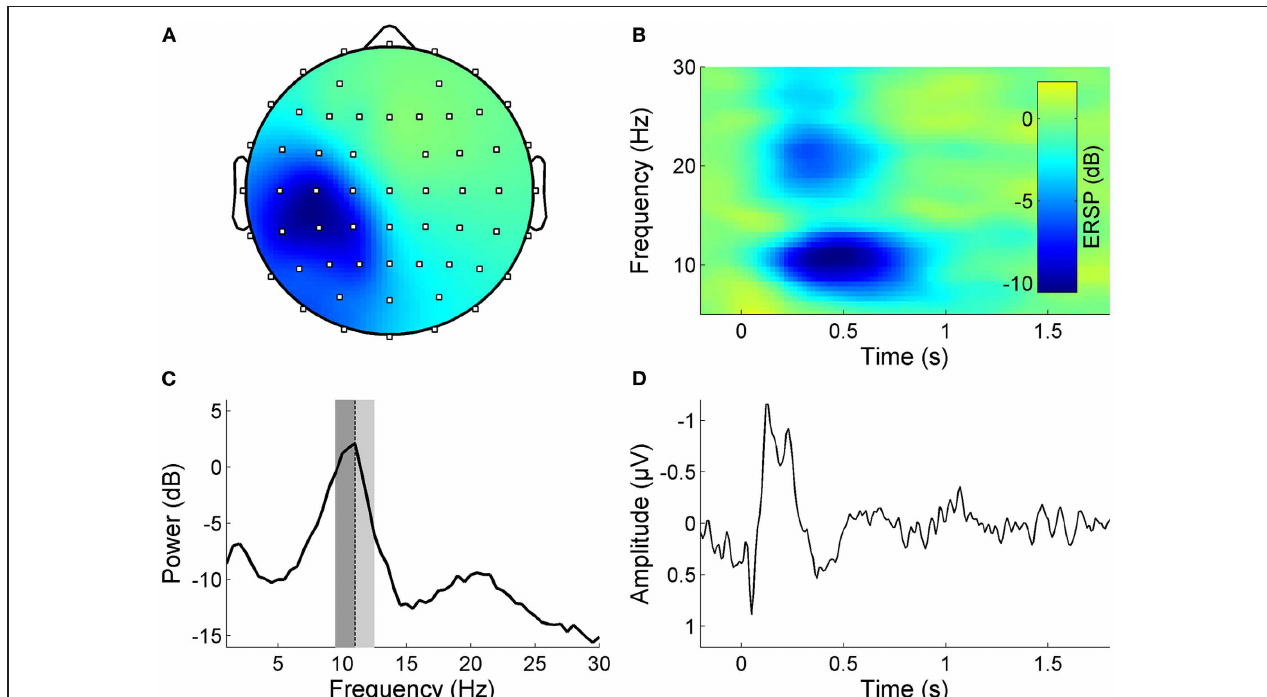
FIGURE 1 | Properties of a somato-IC reflecting sensorimotor activity in a representative subject. (A) Scalp map projection of IC weights (dots display channel locations, color-coding as in panel B , but unitless). The projection shows a lateralized somatosensory topography with a peak contralateral to the stimulation site. (B) Time-frequency image showing ERSP, which is the relative change in event-related power at different frequencies, time-locked to